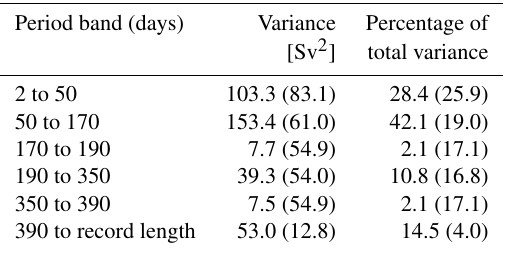
Table 3. Distribution of variance in the indicated period bands in the DWBC transport calculated from the PIES/CPIES observations during the continuous 2011–2014 window. The observed DWBC transport was integrated between 800 and 4800dbar and between the original PIES at sites A and D. Values for transport integrated only between the PIES at sites A and B are shown in parentheses.